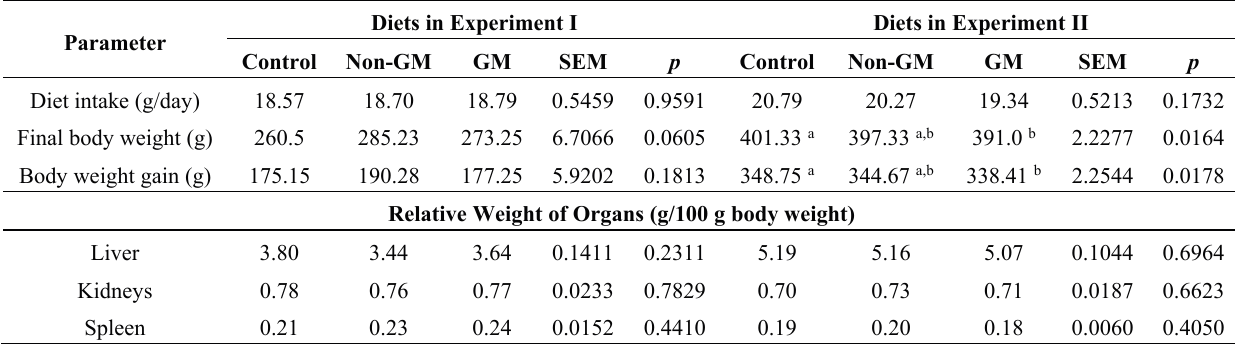
Figure 1. Apparent digestibility of dietary nutrients (%). Error bars indicate standard error of the mean (SEM). Statistically significant effect: values of one parameter without common letter (A, B, C), are statistically significantly different ( p < 0.01). Table 1. Selected parameters of rat growth and development.